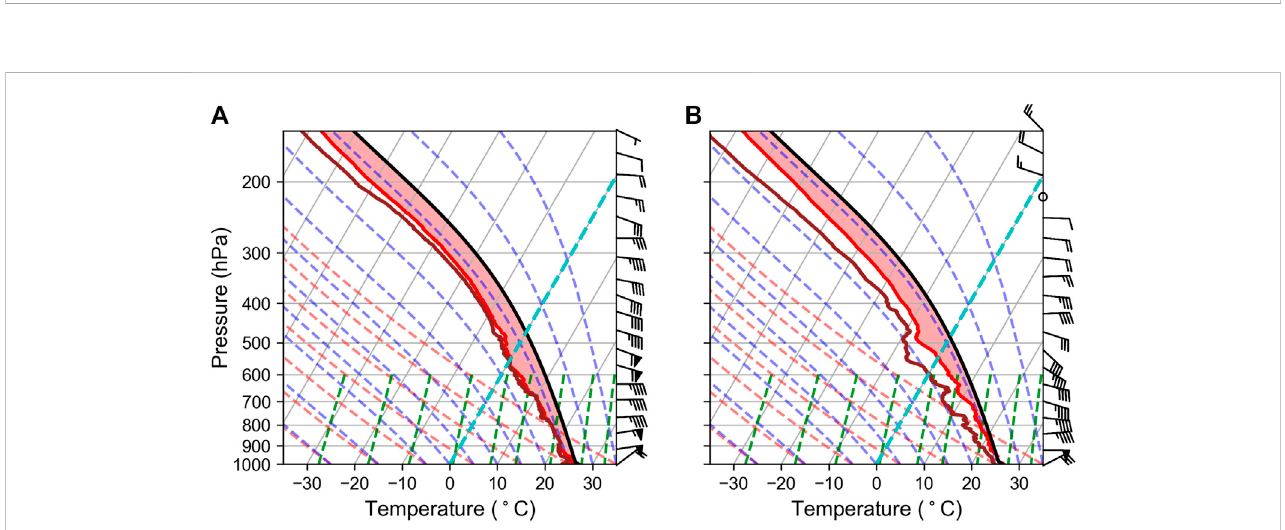
FIGURE 4 The skew T-lnP diagram of Sansha meteorological station at 19:16 on 16 October (A) , and 01:18 on 17 October (B) . The brown and red solid lines are the dew point temperature and temperature pro fi le, respectively.